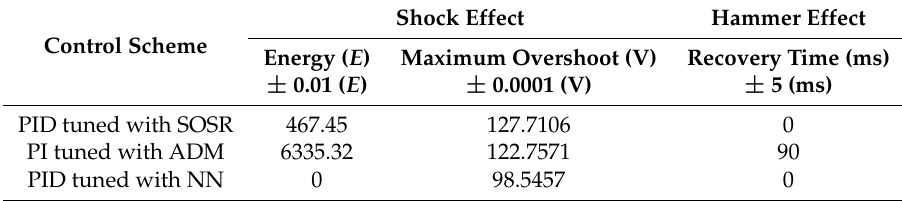
Table 3. Metrics for the control scheme comparison for hammer and shock